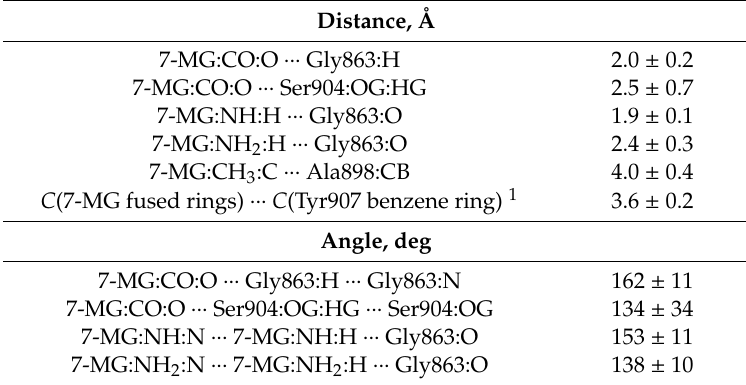
Figure 1. Interactions of 7-MG molecule in the PARP-1 active site revealed by MD simulation: hydrogen bonds with Gly863 and Ser904, π -stacking of purine rings with Tyr907, and hydrophobic contact between the 7-MG methyl group and Ala898. Table 1. Distances and angles describing 7-MG position in the PARP-1 active site determined by the 20-ns MD simulation. Mean values are presented with standard deviations.